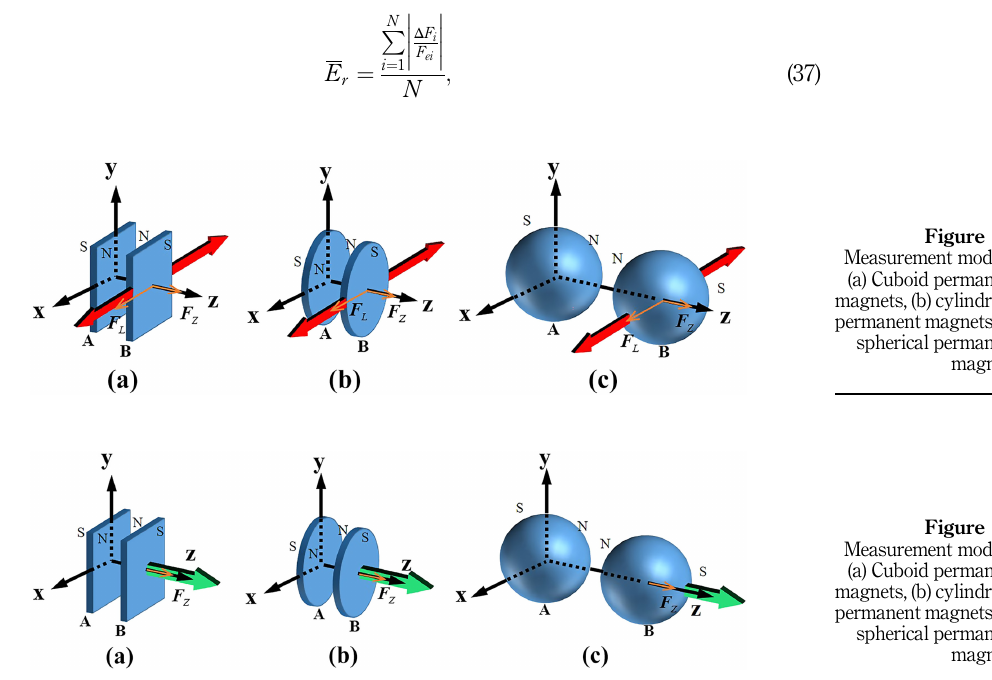
Figure 16. Measurement mode